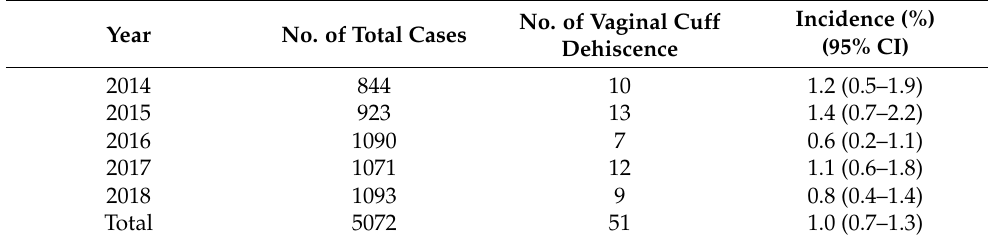
Table 1. Number of cases of hysterectomies involving colpotomy and vaginal cuff dehiscence in each year of the